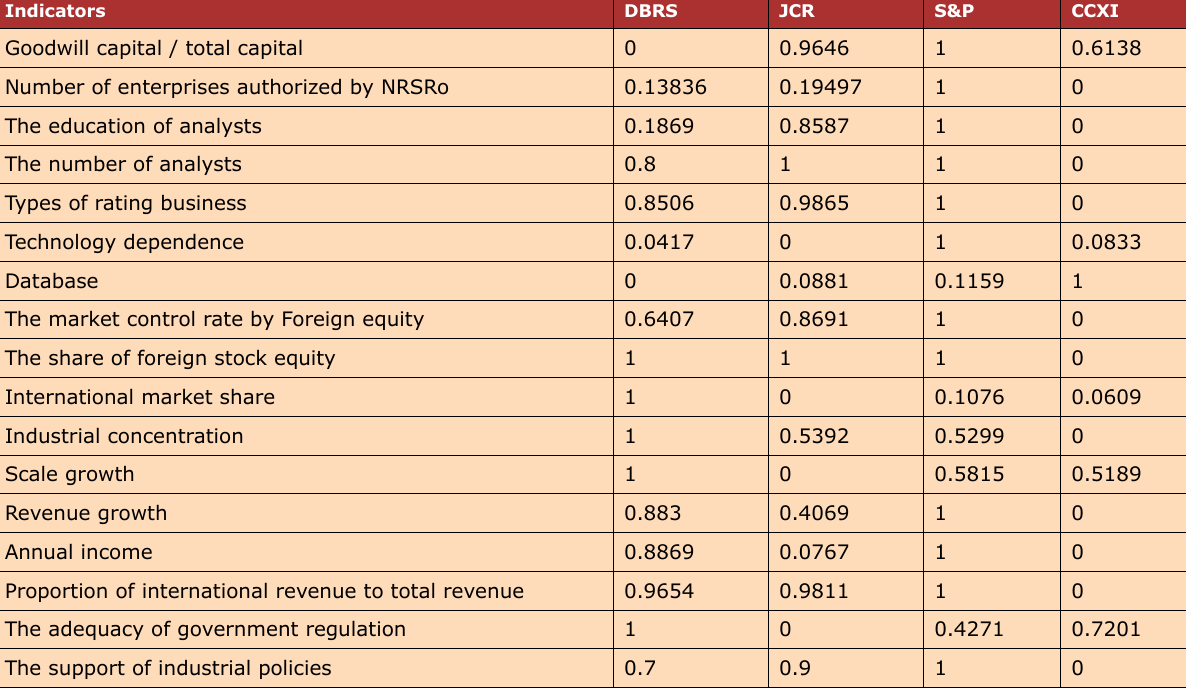
Table 4. The Standardization of Data